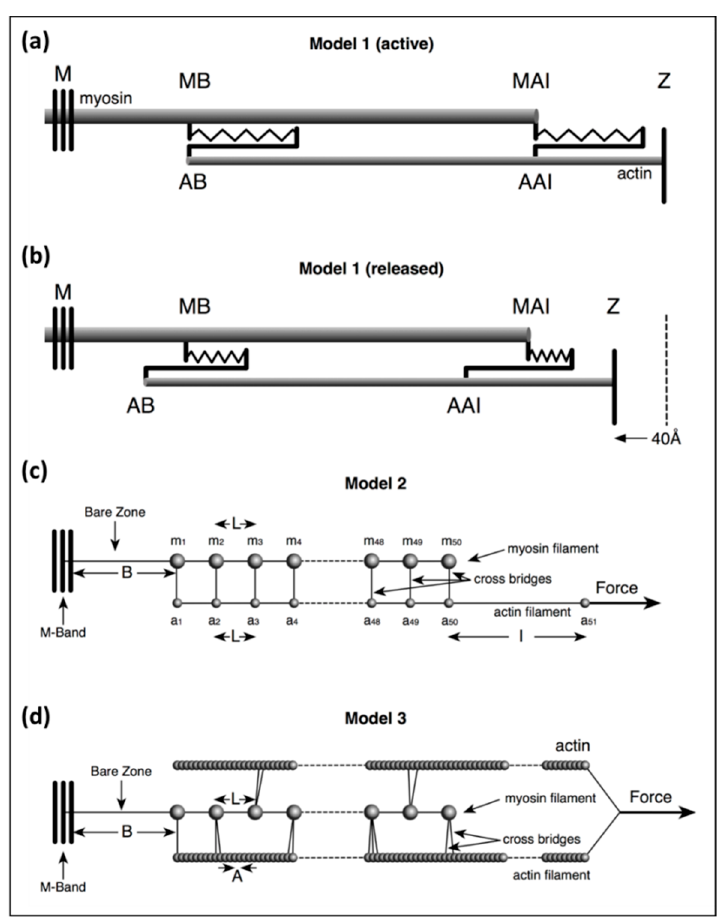
Figure 2. Illustrations of the three different models of increasing complexity used in the calculations in this paper. ( a , b ) Model 1 allows a simple and approximate evaluation of filament and cross-bridge stiffnesses to show roughly what they must be: ( a ) at the isometric force plateau P o before release, and ( b ) after release to zero tension. In ( a ): MB: edge of the myosin filament bare zone; MAI: the end of the myosin filament at the A-I junction; AB: the tip of the actin filament away from the Z-band; AAI: the actin filament position at the A-I junction. ( c ) Model 2 mimics cross-bridges at levels m1, m2 etc., attaching to actin positions a1, a2 etc., at 144.9 Å intervals with appropriate weighting to allow for binding to actin by only a fraction of the available heads at any one time. ( d ) Model 3 represents, in a simplified way, the kind of result from assessing myosin head labelling realistically in three dimensions (3D) using the program MusLABEL [19]. For details see text.